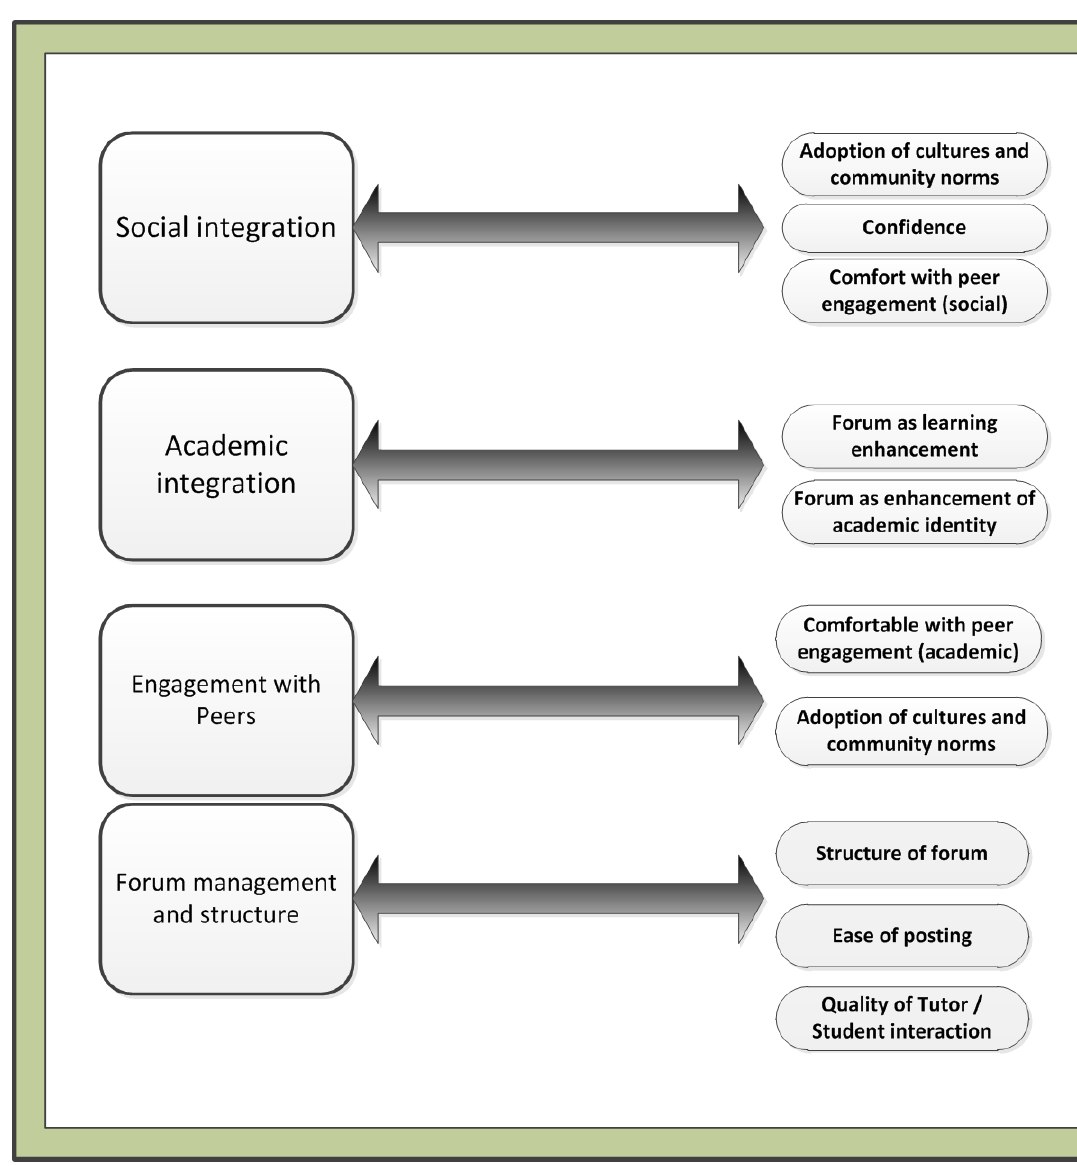
Figure 3 . Elements of data